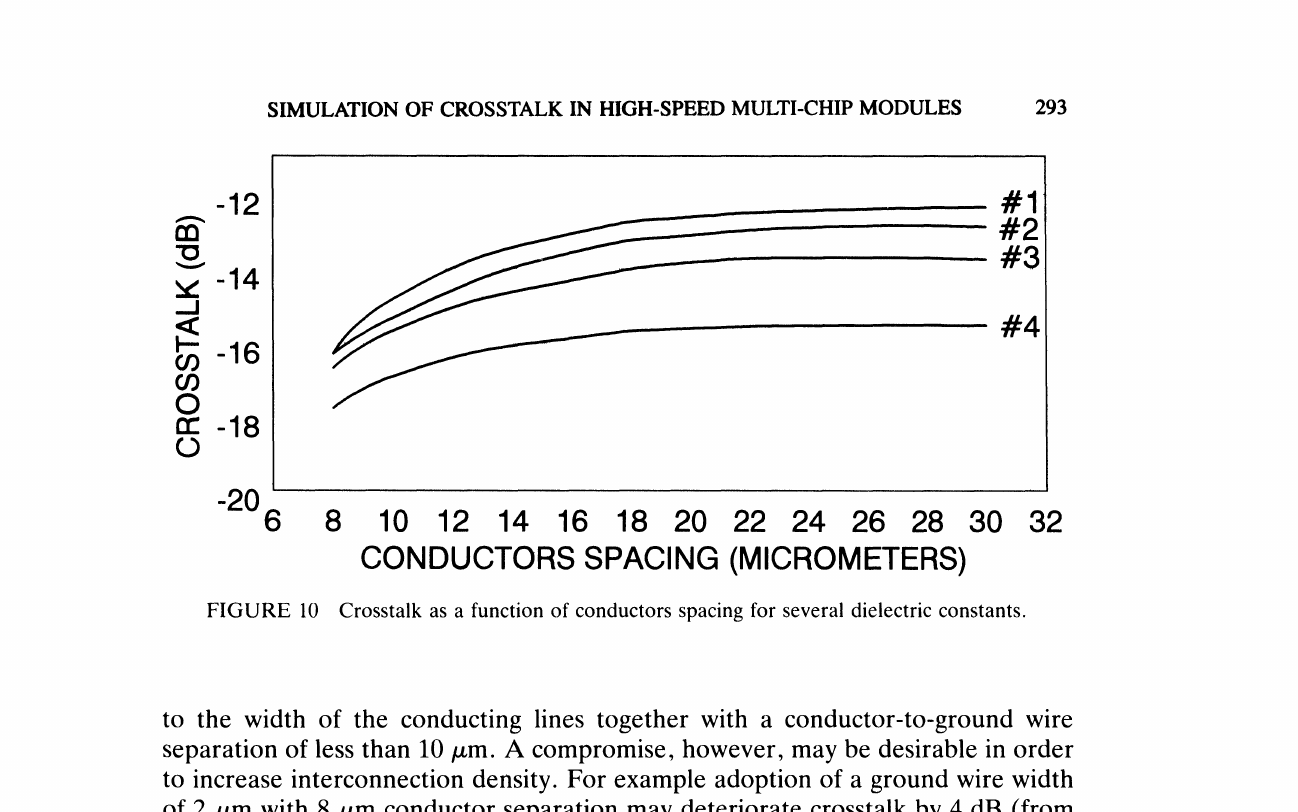
FIGURE 10 Crosstalk as a function of conductors spacing for several dielectric constants.